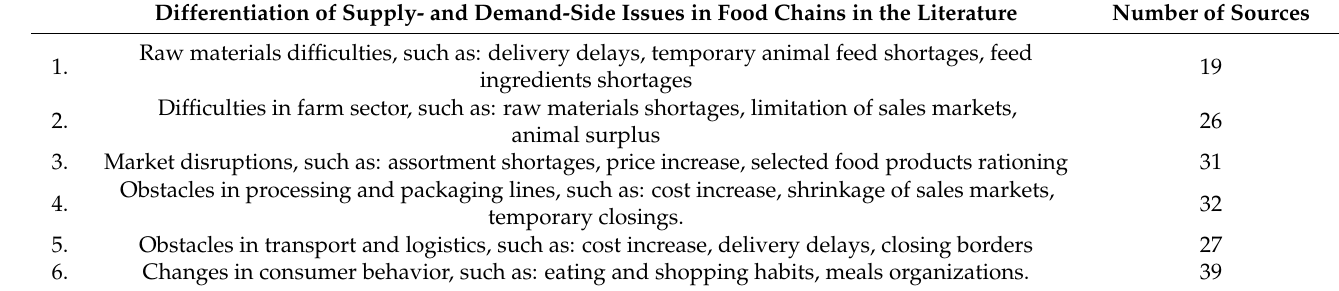
Table 2. Presentation of the supply-side and demand-side issues in maintaining continuity of food supply chain during COVID-29 pandemic in the